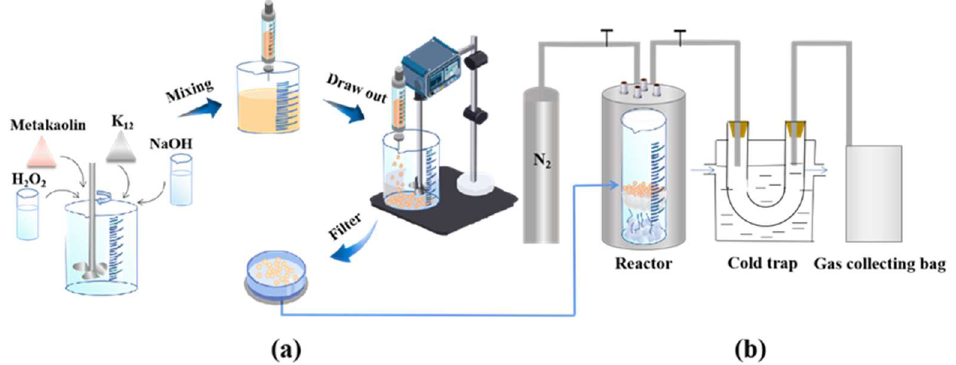
Figure 7. Flow chart of NMGM thermal catalytic cracking of waste LDPE: ( a ) Microsphere preparation process, ( b ) NMGM thermal catalytic cracking of LDPE waste.